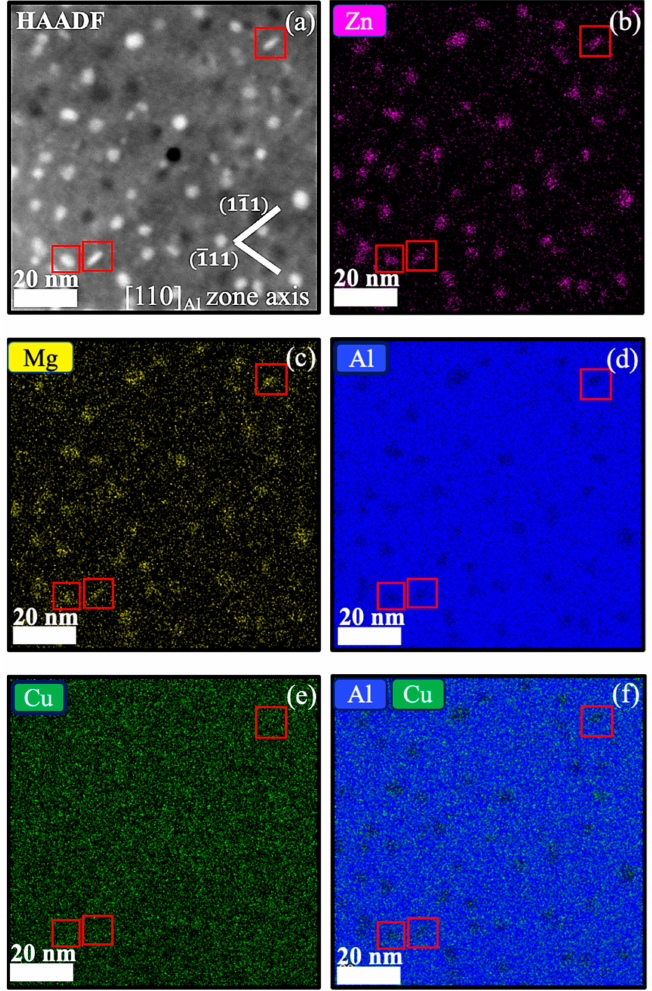
Figure 8. STEM-HAADF image with EDX mappings of η (cid:48) precipitates of 7075-HCu in the 120 ◦ C PA condition: ( a ) STEM-HAADF image; ( b – e ) EDS maps of Zn, Mg, Al, and Cu; ( f ) overlapped Al and Cu maps. η (cid:48) precipitates were indicated by the red